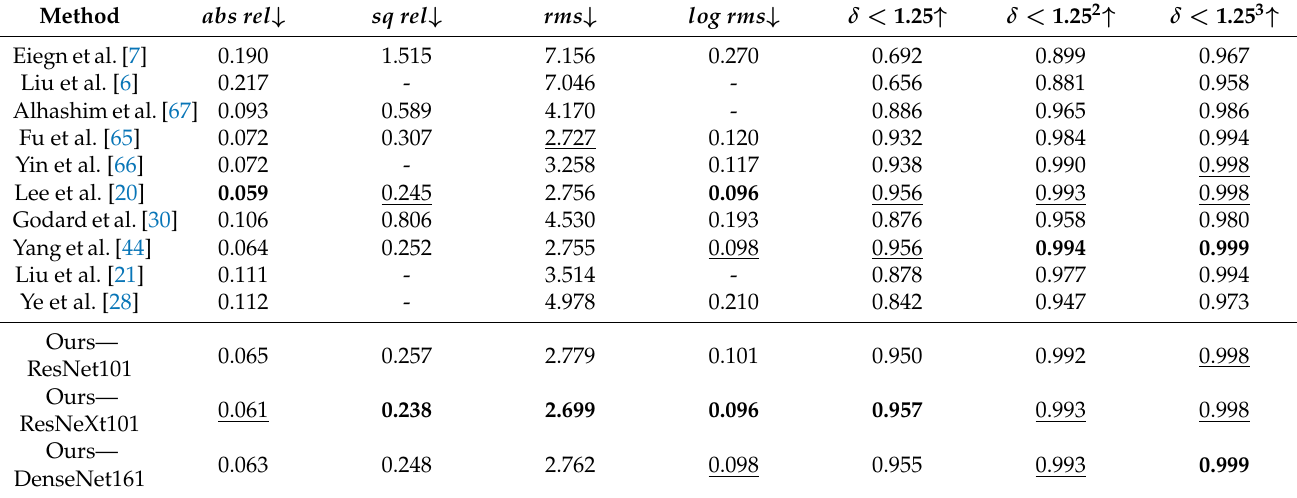
Table 2. Quantitative results on the KITTI Eigen test split. The best results of every metric among these works are marked in bold type, while the second best ones are underlined. We employ three encoders for our method, i.e., ResNet101, ResNeXt101 and DenseNet161. Note that the maximum depth of these methods are all set to 80 m. Metrics indicated by ↓ : lower is better; metrics indicated by ↑ : higher is